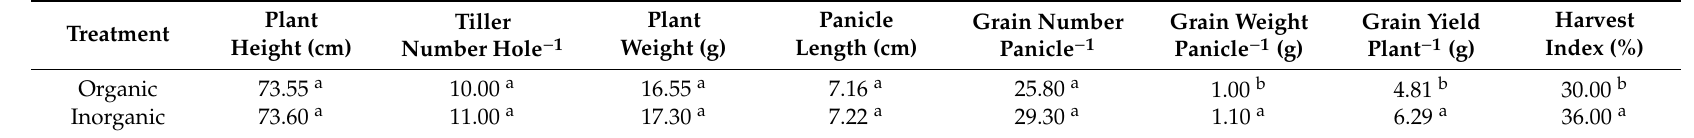
Table 2. Mean comparison of growth and yield components of wheat under di ff erent types of fertilizers.